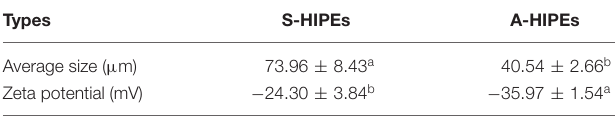
TABLE 2 | Average size and ζ -potential of A-HIPEs and